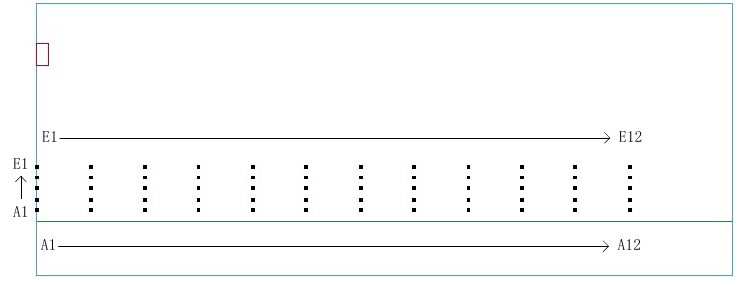
Figure 3. Distribution of gauges at di ff erent